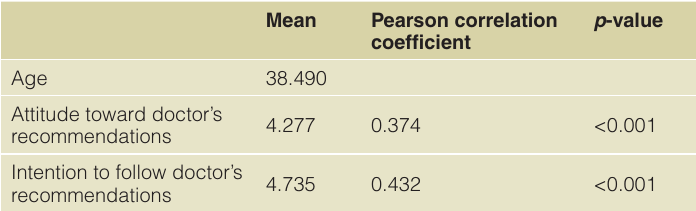
Table 6. Effects of age: results of the correlation